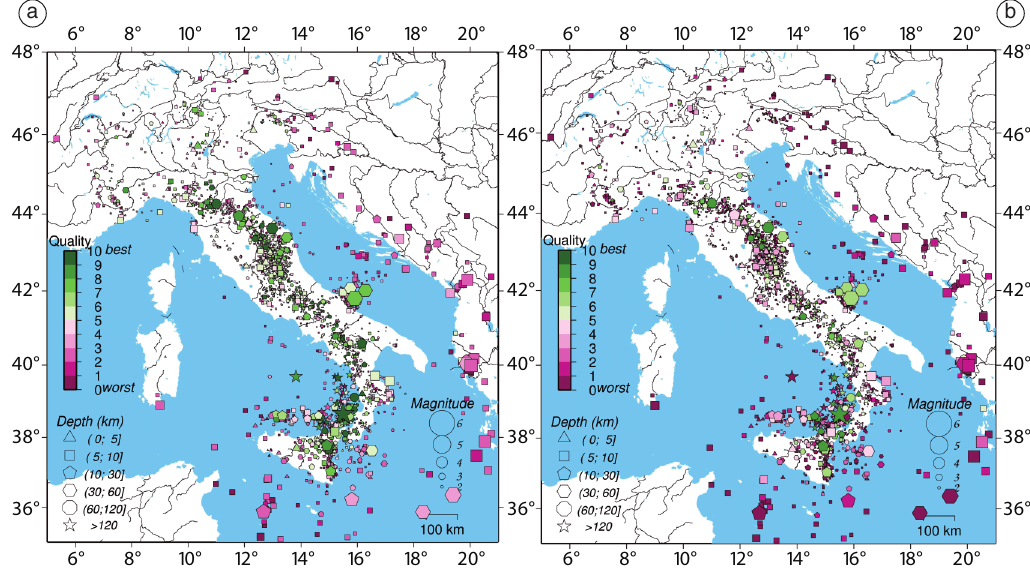
Fig. 9a,b. Epicentral maps of year 2006, showing location quality of revised bulletin (a) and automatic (b) epi- centers. The colours are relative to the combined quality factor (normalized from 0 to 10) based on network geometry and statistical location errors (see text and tables III and IV for details). Symbol size is proportional to the magnitude, symbol type depend on hypocentral